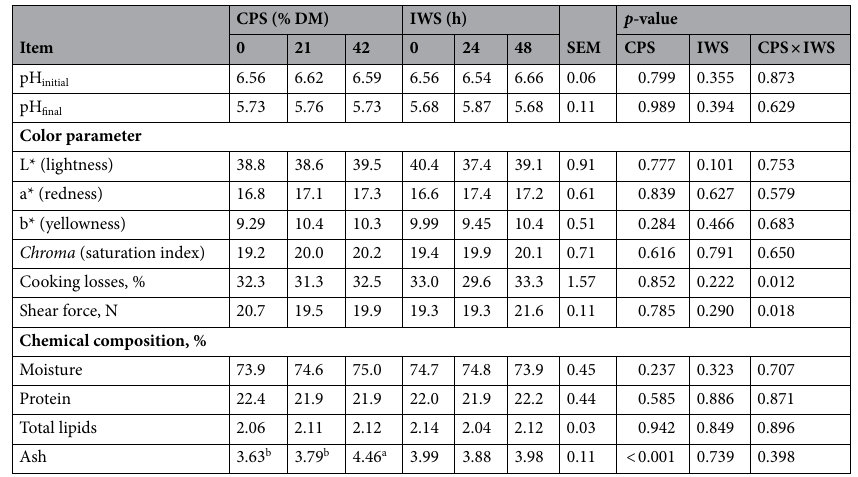
Table 4. Physicochemical composition of the Longissimus lumborum muscle of goats fed with cactus pear silage (CPS) and submitted to intermittent water supply (IWS). a,b Means within rows with different letter superscripts differ by Tukey test ( p < 0.05).